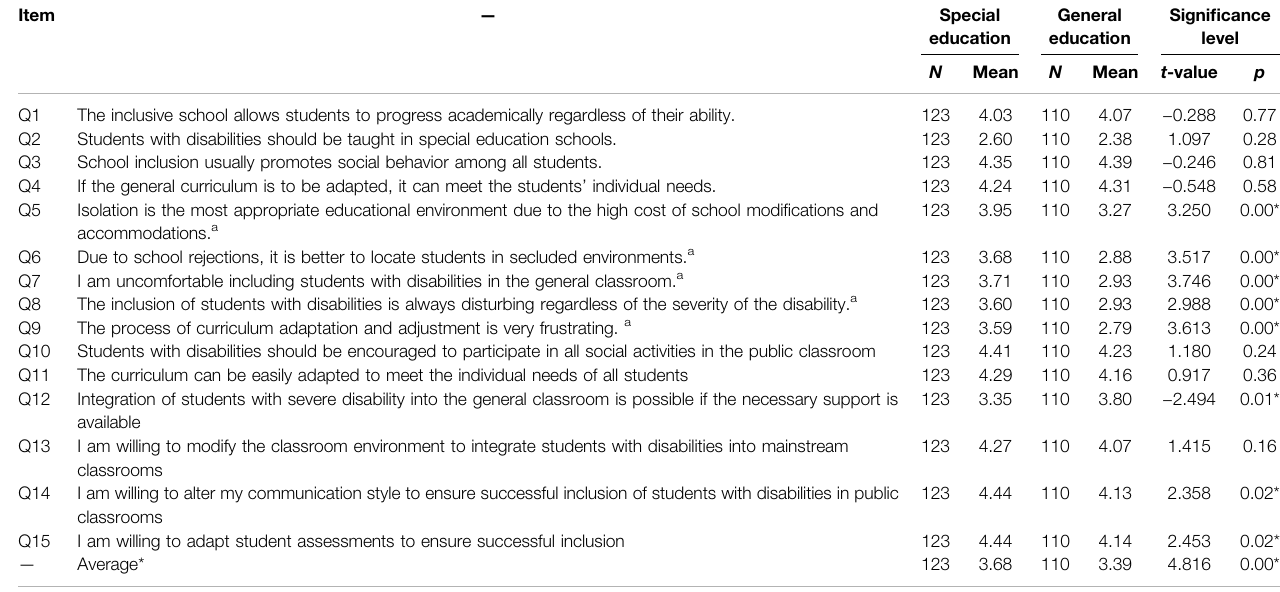
TABLE 4 | T -test comparison of attitudes for both special education and general education teachers. Item